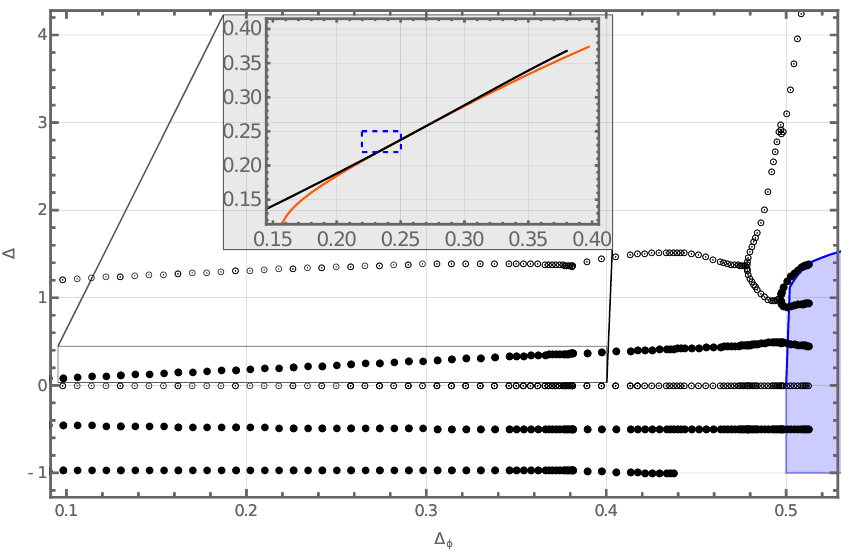
Figure 12 . Spin 0 roots of the extremal functional in 3 dimensions evaluated at decreasing values of ∆ φ . Single roots are denoted by filled circles and double roots are denoted by dotted circles. The Blue line shows the extremal gap obtained by semi-definite programming. The orange line in the subplot shows the spin-zero single root in the deformation discussed in the previous section. The dashed blue region in the inlay is the expected scaling dimension from the (cid:15)